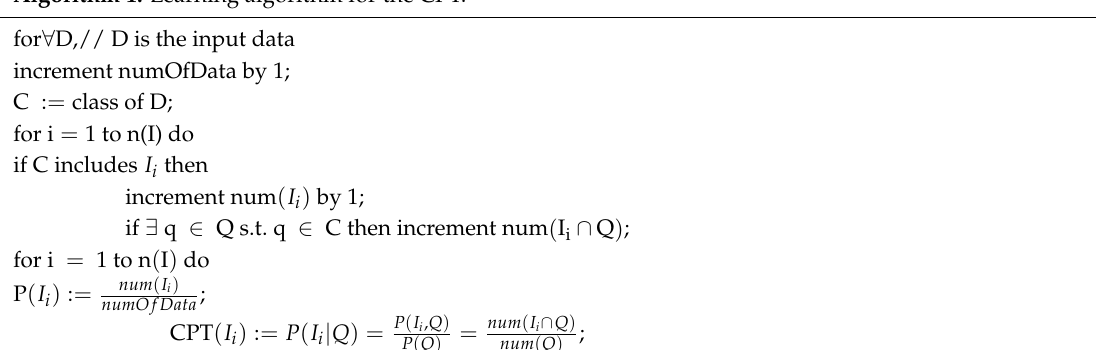
Algorithm 1. Learning algorithm for the